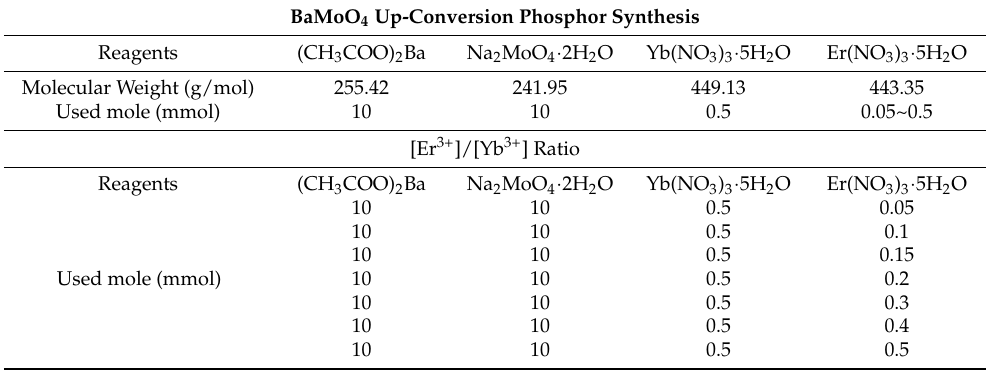
Table 1. Reagents and moles used in the